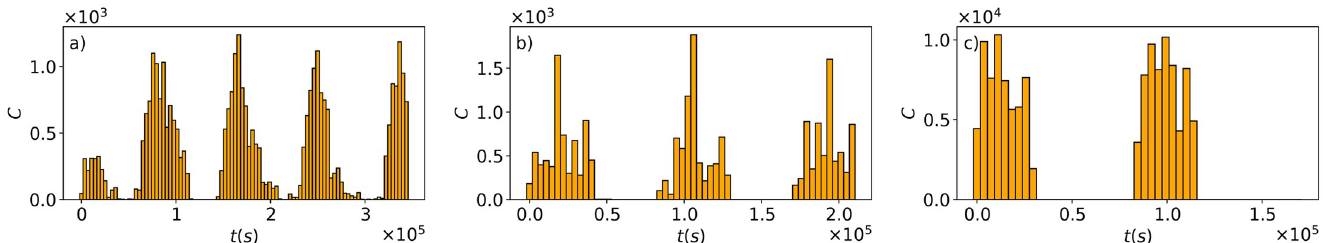
Fig 3. The periodic behavior of the number of contacts for 3600s aggregated time intervals for the a) Hospital Network, b) Conference Network and c) Primary School Network.